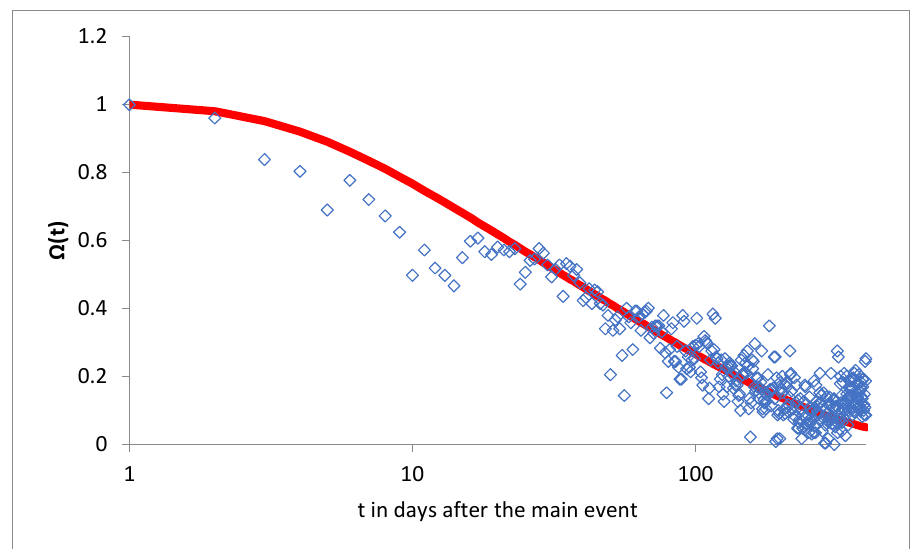
Figure 6. The experimentally estimated Ω ( t ) function for the first 400 days of the post-seismic relaxation after the Lefkas main event, along with the calculated one using Equation (16) for τ min ≈ 3.5 days and τ max ≈ 350 days, respectively.